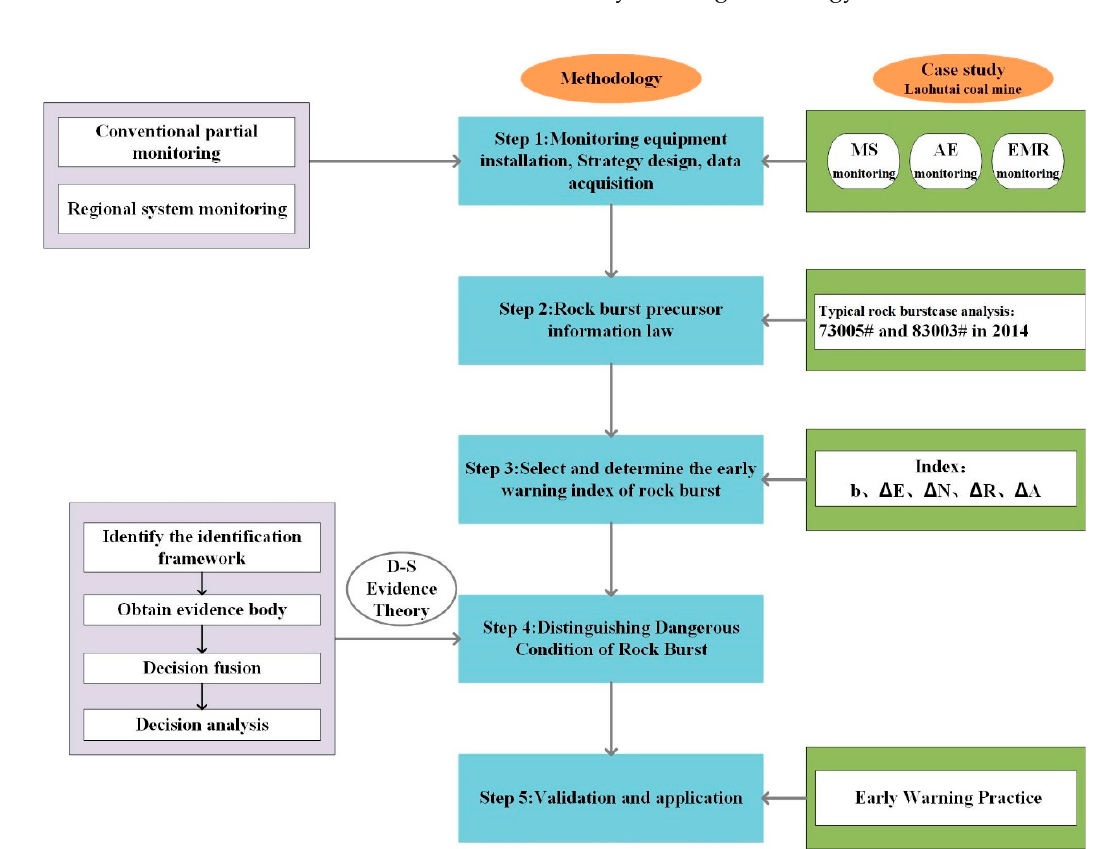
Figure 12. Flowchart of combined early warning method of